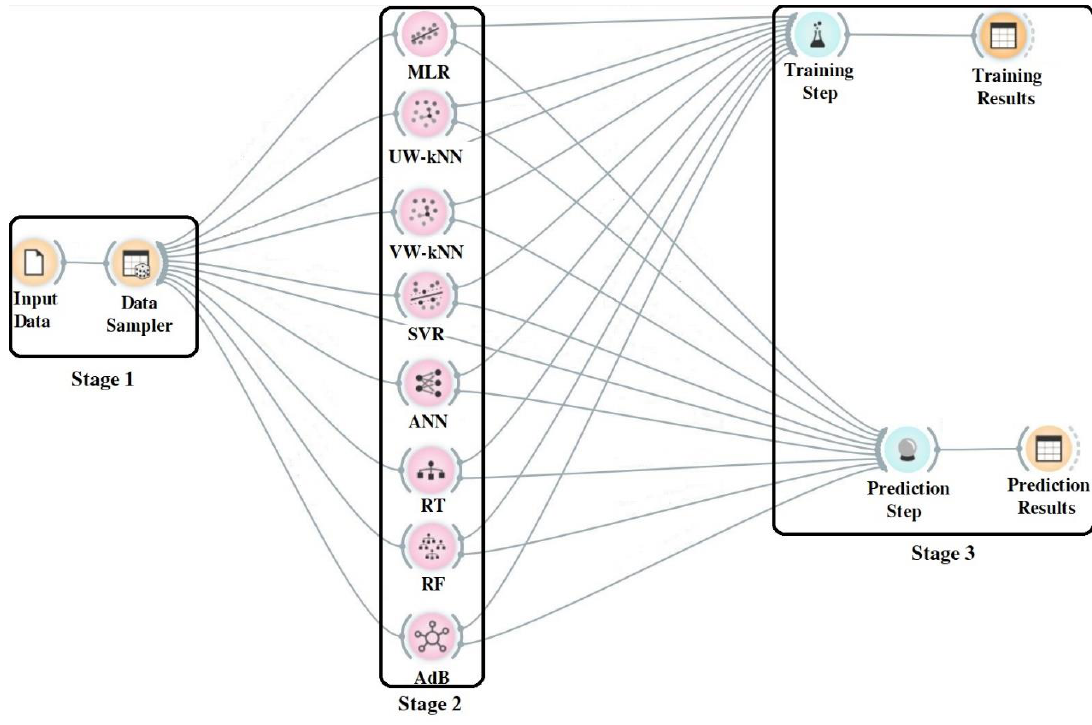
Figure 1 . Schematics of the modeling steps in this study . Figure 1. Schematics of the modeling steps in this